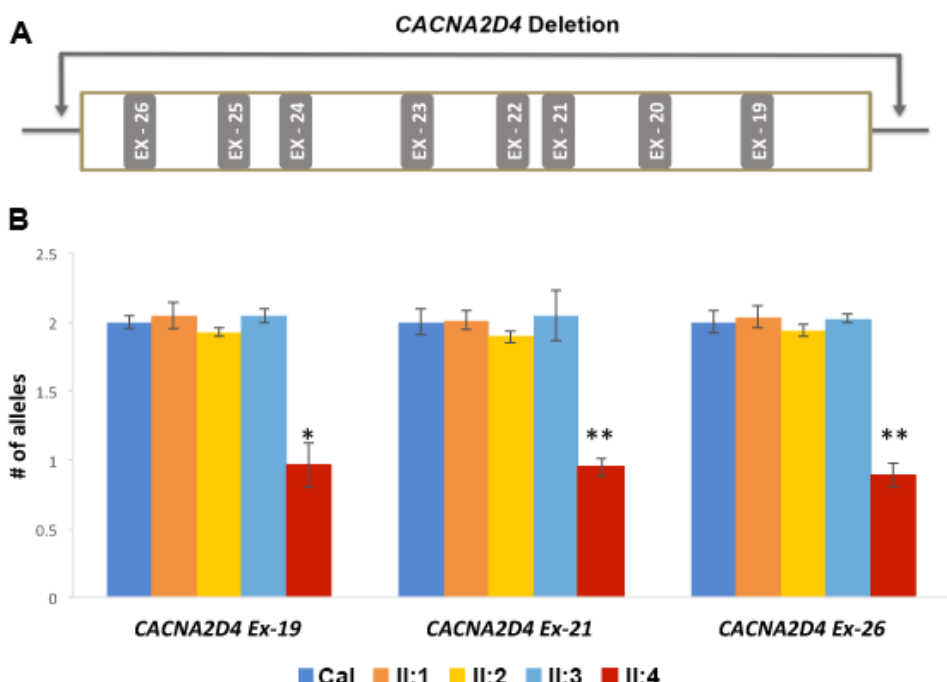
Figure 6. Quantitative polymerase chain reaction (qPCR) analysis of the CACNA2D4 sequence with a large heterozygous deletion in pedigree RF.L.11.10. ( A ) Region spanning a 30 kb heterozygous deletion (Chr12: 1,949,399–1,980,050) observed in CACNA2D4 gene in patient II:4 in pedigree RF.L11.10. This deletion includes 8 exons (exon 19 to exon 26) of the CACNA2D4 gene; ( B ) qPCR of exons 19, 21 and 26 of CACNA2D4 indicated the presence of two wild type alleles of CACNA2D4 in II:1, II:2 and II:3; and a single copy of CACNA2D4 exon 19, 21 and 26 in II:4. The qRT-PCR was normalized to two reference genes, GPR15 and ZNF80 and Control human genomic DNA was used as calibration control (Cal) to determine the copy number of each allele present in the test samples. * p < 0.05; ** p < 0.01.